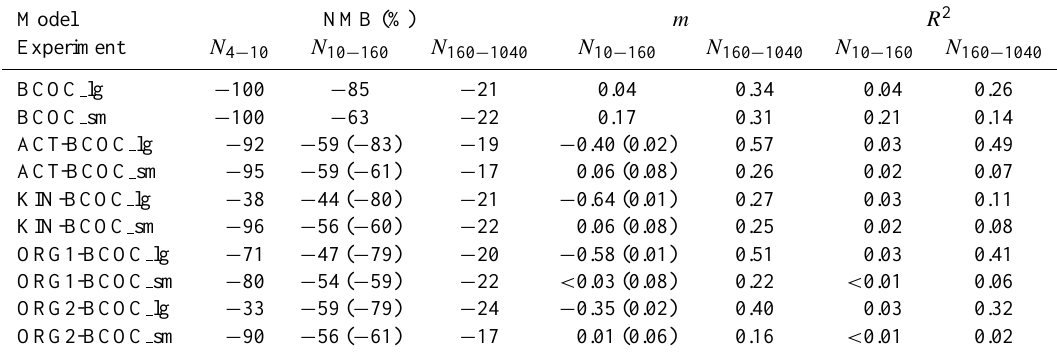
Table 5. Summary statistics for particle number concentrations in the diameter ranges; 4–10nm ( N 4 − 10 ), 10–160nm ( N 10 − 160 ), and 160– 1040nm ( N 160 − 1040 ). The normalised mean bias (NMB), slope of the linear regression ( m ) and correlation coefficient ( R 2 ) are calculated between the simulated and observed mean number concentrations in the BL ( ≤ 2000m a.s.l.) for each flight performed by the DLR Falcon aircraft during LONGREX, May 2008. R 2 and m are not given for N 4 − 10 for reasons explained in Sect. 4.2. Values in brackets are statistics calculated with 1 flight (the second flight on 22 May)